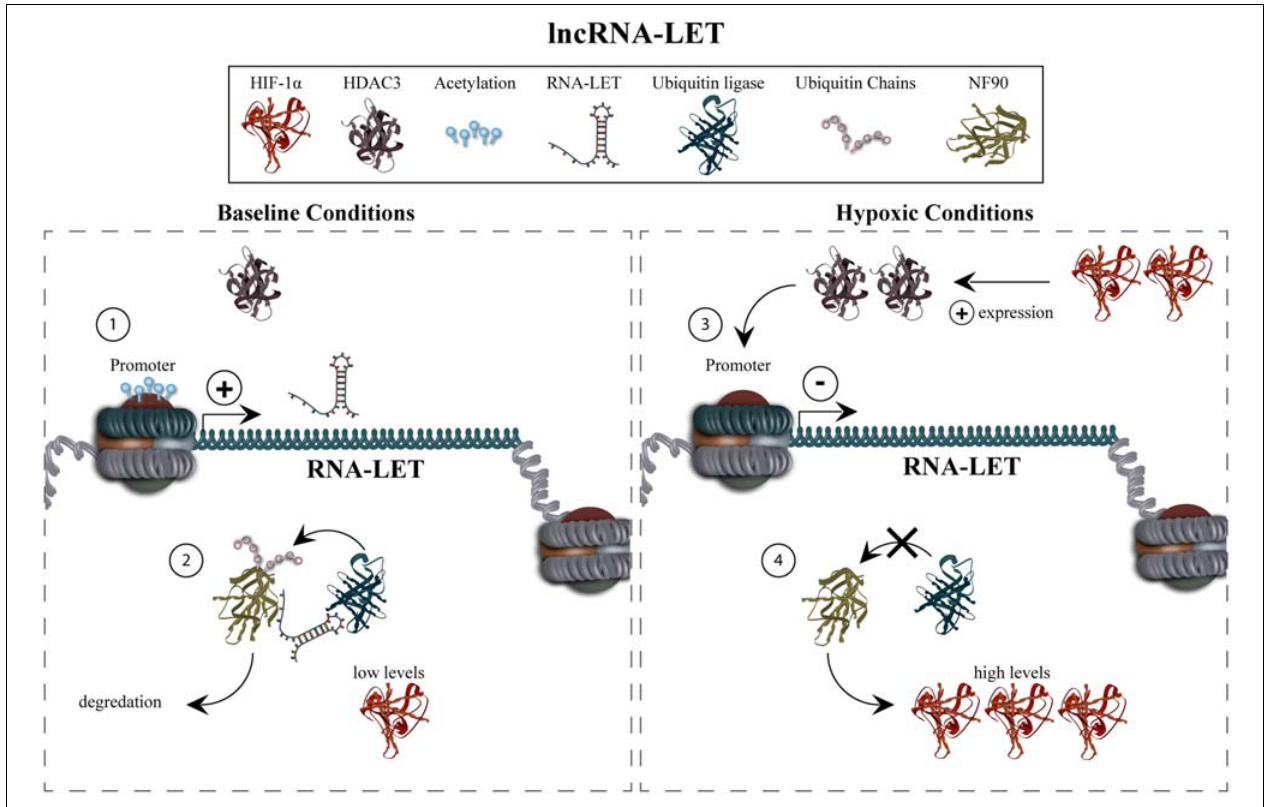
results in decreased expression of lncRNA-LET which, in turn, causes decreased ubiquitination of NF90, and thus accumulation of HIF -1 α via a positive-feedback mechanism (4). The recruitment of HDAC3, which results in deacetylation of the lncRNA-LET promoter, is currently